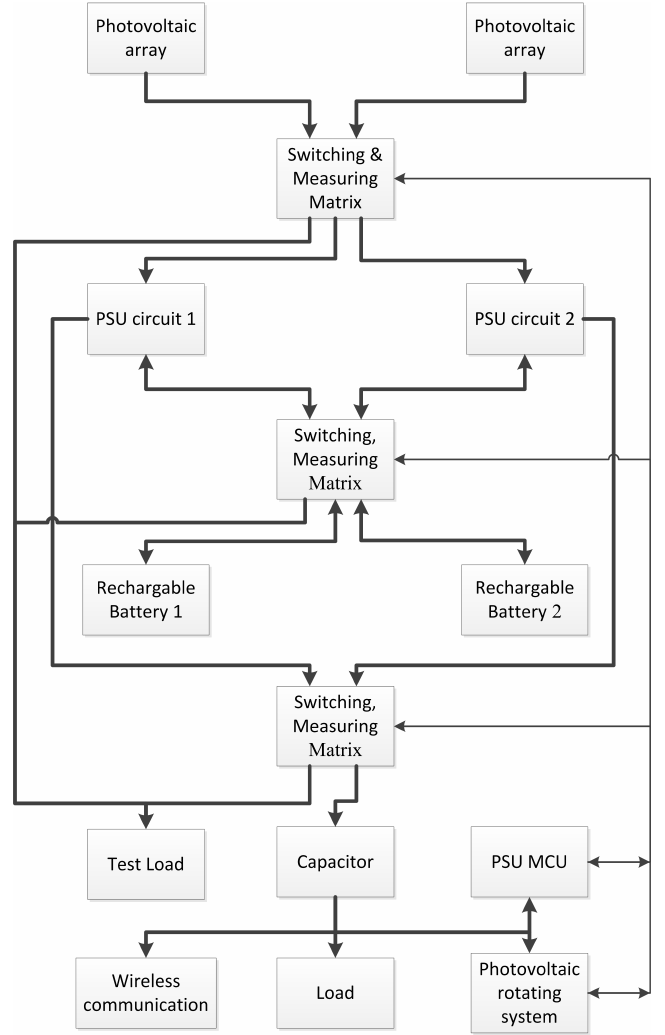
Figure 3. Simplified redundant modular power supply unit